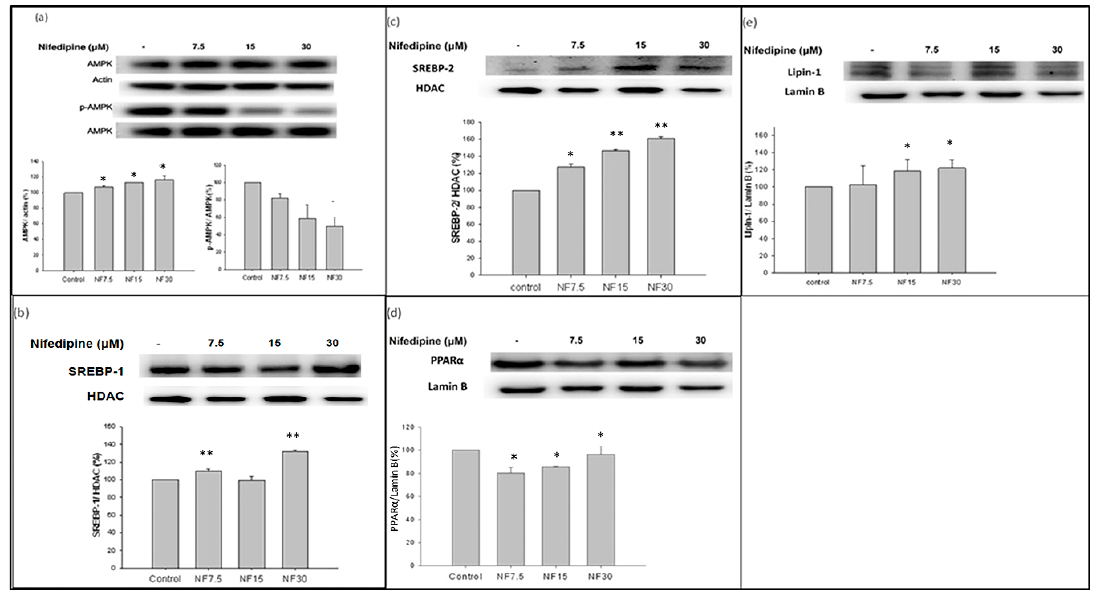
Figure 6. Nifedipine and the expression p-AMPK, SREBP-1/2(nuclear), PPAR- α (nuclear) and lipin-1 (nuclear) in 48 h. ( a ) The AMPK/actin was upregulated to 107.1%, 112.6%, and 116.4%, significantly at doses of 7.5, 15, and 30 µM ( p < 0.05), the ratio p-AMPK/AMPK was downregulated to 82.1%, 58.7%, and 49.9%, respectively. ( b , c ) SREBP-1 was activated in control. The SREBP-1/HDAC was upregulated to 109.9% and 132.0% by nifedipine at doses of 7.5 and 30 µM, respectively ( p < 0.01); The SREBP-2 were elevated to 127.5%, 146.7% and 161.0% by nifedipine at doses of 7.5, 15 and 30 µM, respectively ( p < 0.05 in 7.5 µM, p < 0.01 in 15 and 30 µM) ( d ) nifedipine downregulated PPAR- α . The PPAR α /Lamin B was suppressed from 80.2%, 85.6%, to 96.4% compared to control (100%) upon administration of nifedipine at doses 7.5, 15 and 30 µM, respectively. ( p < 0.05 in 15 and 30 µM) ( e ) Lipin-1 was activated in control. The lipin-1/lamin B was upregulated after nifedipine treatment to 102.5%, 115.8% and 121.1%, respectively, by nifedipine at doses of 7.5, 15, and 30 µM, respectively ( p < 0.05 in 15 and 30 µM). p -values ≤ 0.05 (marked as *) were considered statistically significant. In addition, p -values ≤ 0.01 are marked as **.